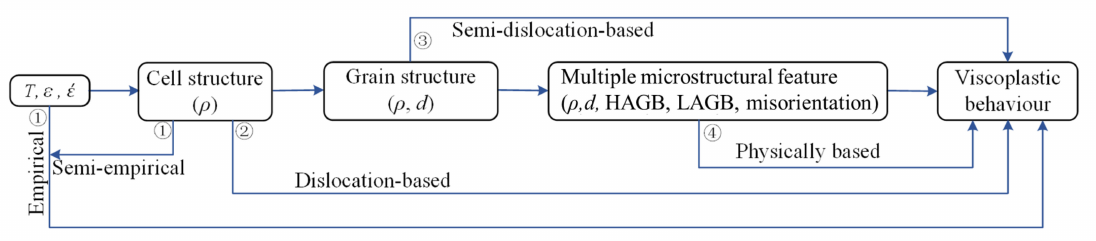
Figure 16. Description of di ff erent types of modelling